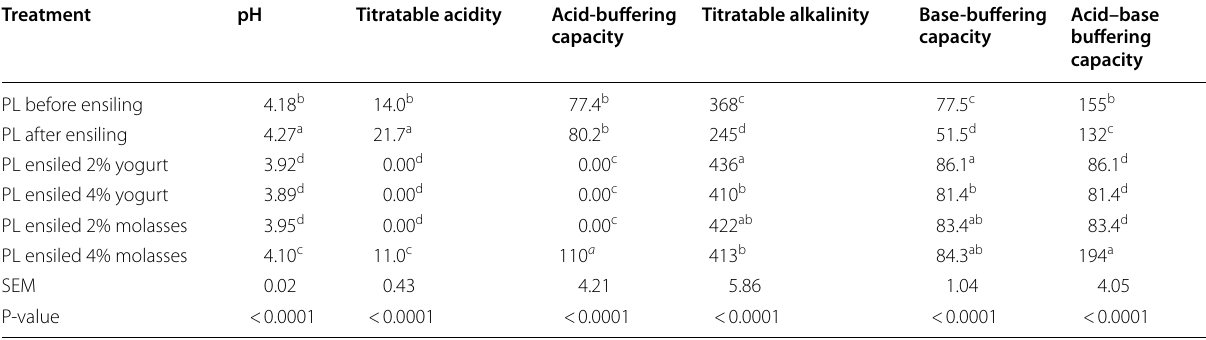
Means within columns followed by the same letter are not different PL pomegranate leaves SEM standard error of the